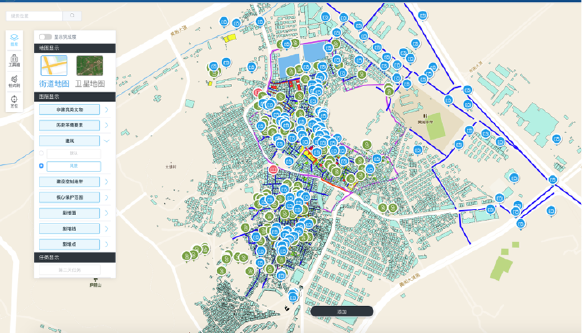
Figure 17 . Collection Results of Dajing & Lianxi Traditional Villages.